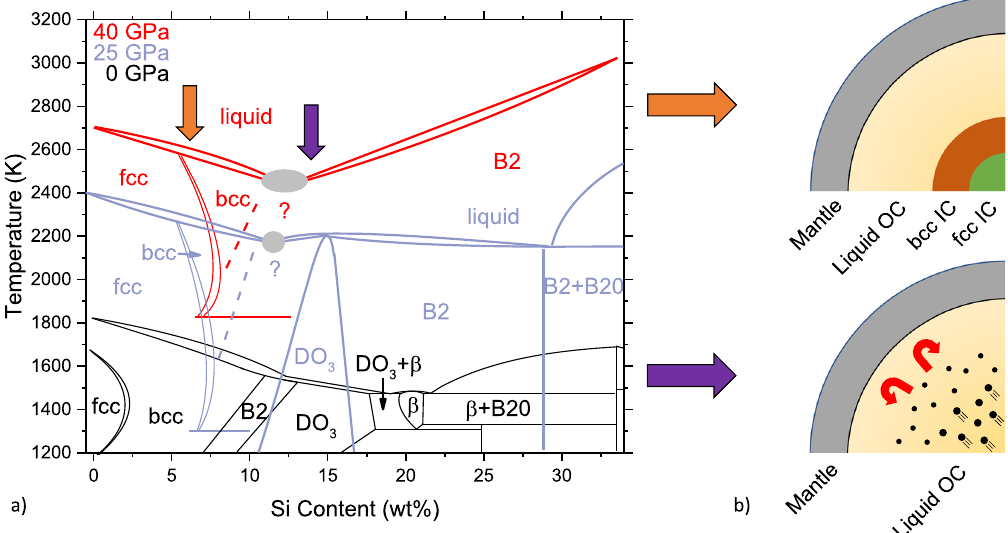
Fig. 5 Temperature – composition phase diagram of the Fe – Si system and possible core crystallization regimes. a The temperature – composition (T-X) phase diagram of the Fe – FeSi system at 25 and 40 GPa from the present study, and the ambient pressure phase diagram from literature 30,34,35 . Phase diagrams at 25 and 40 GPa with datapoints are shown in Supplementary Figs. 10 and 11. Gray circles and question marks indicate uncertainty over the nature of the invariant point. b Possible scenarios for the structure and crystallization regimes of Mercury for: (i) Si-poor (orange arrows) and (ii) Si-rich (purple arrows) liquid cores. (i) The crystallization of an Fe-rich bcc alloy at compositions near the fcc – bcc boundary can lead to the progressive crystallization of an innermost fcc core surrounded by a solid bcc shell. (ii) The crystallization of more Si-rich material would lead to formation of a solid which is less dense than its corresponding liquid, rising upwards and leading to convection without an inner solid